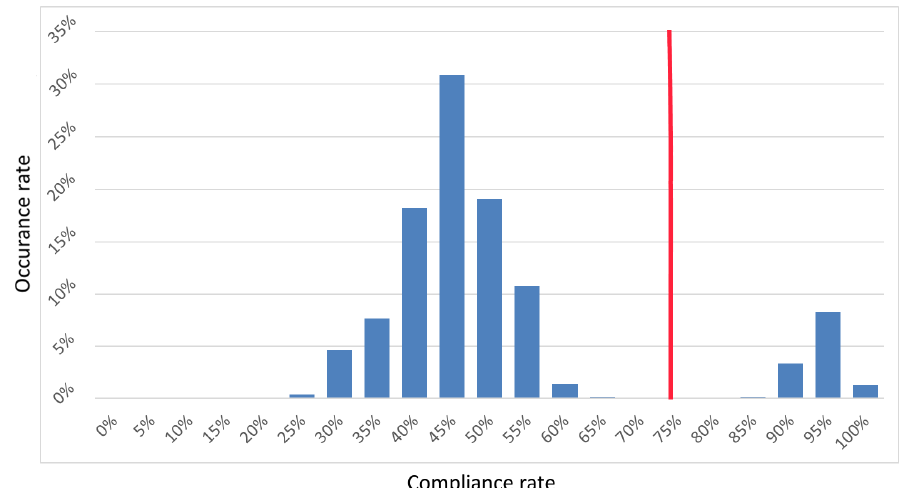
Figure 11. Histogram of the keys’ compliance with two distinguishable normal